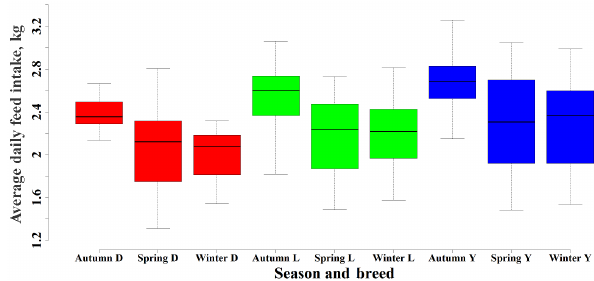
Figure 4. Comparison of daily feed intake weight at different sea- sons. The red, green and blue box plots represent Duroc (D), Lan- drace (L) and Yorkshire (Y), respectively. These breeds have a higher daily feed intake weight in autumn compared to spring and